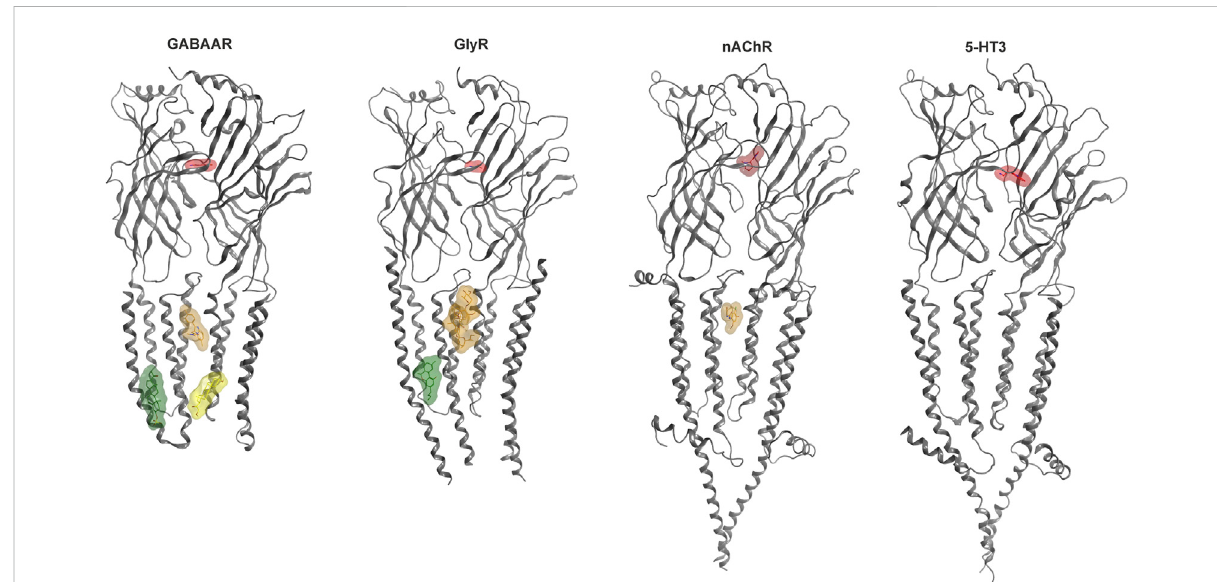
FIGURE 2 Cys-loopreceptorstructureandselectedbindingsites.Foreachfamily,arepresentativedimerisdepictedingreyribbon:GABAAR(8DD2 — Zhu etal.,2022),GlyR(7M6O — Kumaretal.,2022),nAChR(7EKT — Zhaoetal.,2021),5-HT3(6HIO — Polovinkinetal.,2018).Ligandboundstructureshave been superposed to render multiple sites. Agonist molecules at the ECD interfaces are rendered in red: GABA (PDB ID 6HUP — Masiulis et al., 2019), glycine (PDB ID 5VDH — Huang et al., 2017), nicotine (PDB ID 6PV7 — Gharpure et al., 2019), 5-HT (PDB ID 6HIO). Binding sites in the TMD are displayed with representative ligands using colors for distinct sites: The upper TMD interface site in brown: zolpidem bound GABAAR